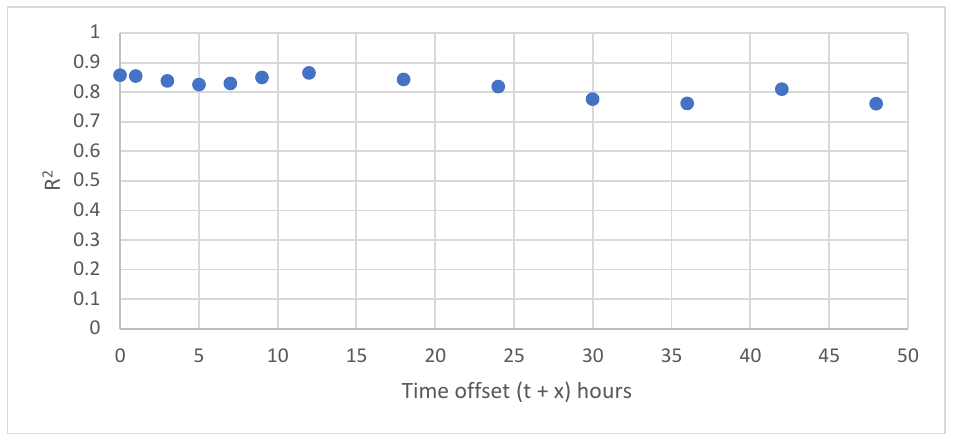
Figure 8. Forecast performance for t + x offset versus time offset of a 4 × 4 t − 24 LSTM-RNN model.